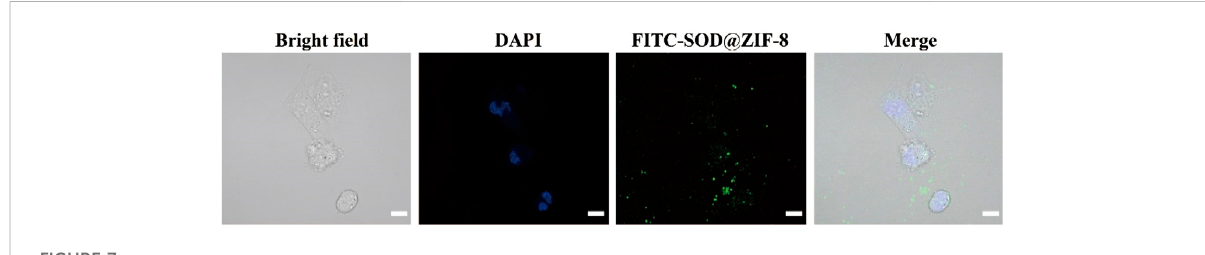
FIGURE 7 Cellular uptake ability of SOD@ZIF-8 detected by CLSM.